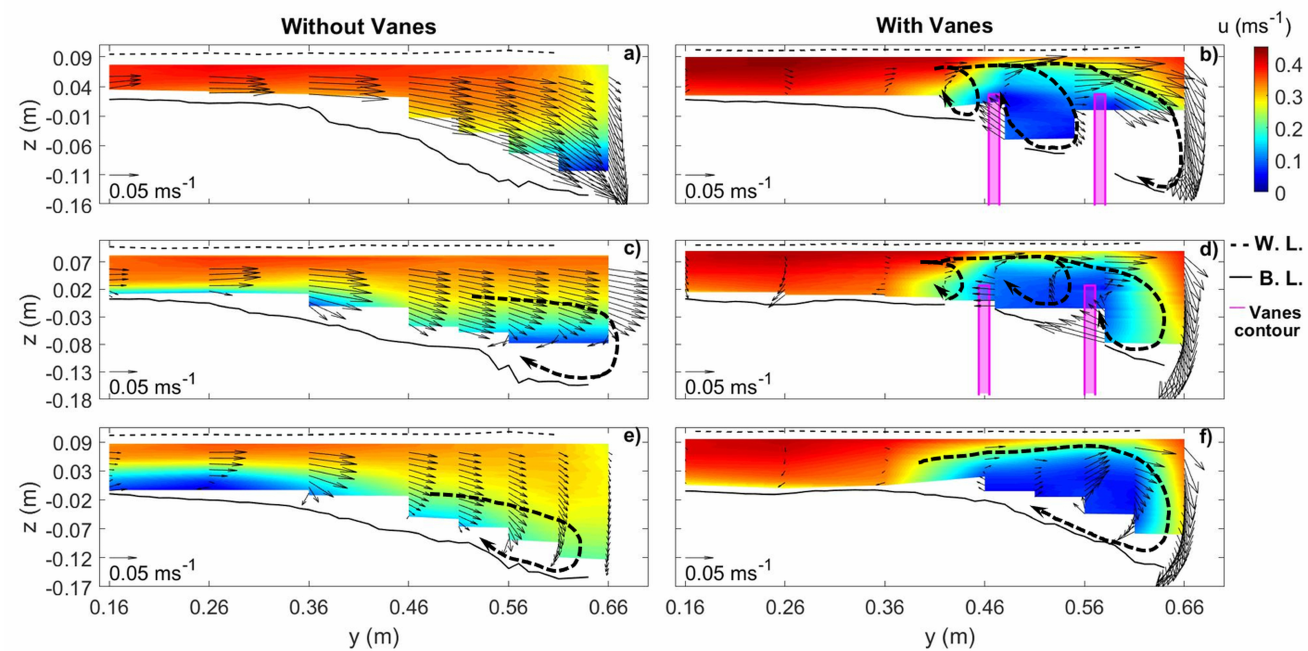
Figure 12. Velocity u (ms − 1 ) as color scale and direction and magnitude of the velocity components ( v , w ) (ms − 1 ) as vector arrows, in the NV and the VF experiments, at cross-sections: ( a ) x = 0.31 m. ( b ) x = 0.30 m. ( c ) x = 0.46 m. ( d ) x = 0.46 m. ( e ) x = 0.56 m. ( f ) x = 0.56